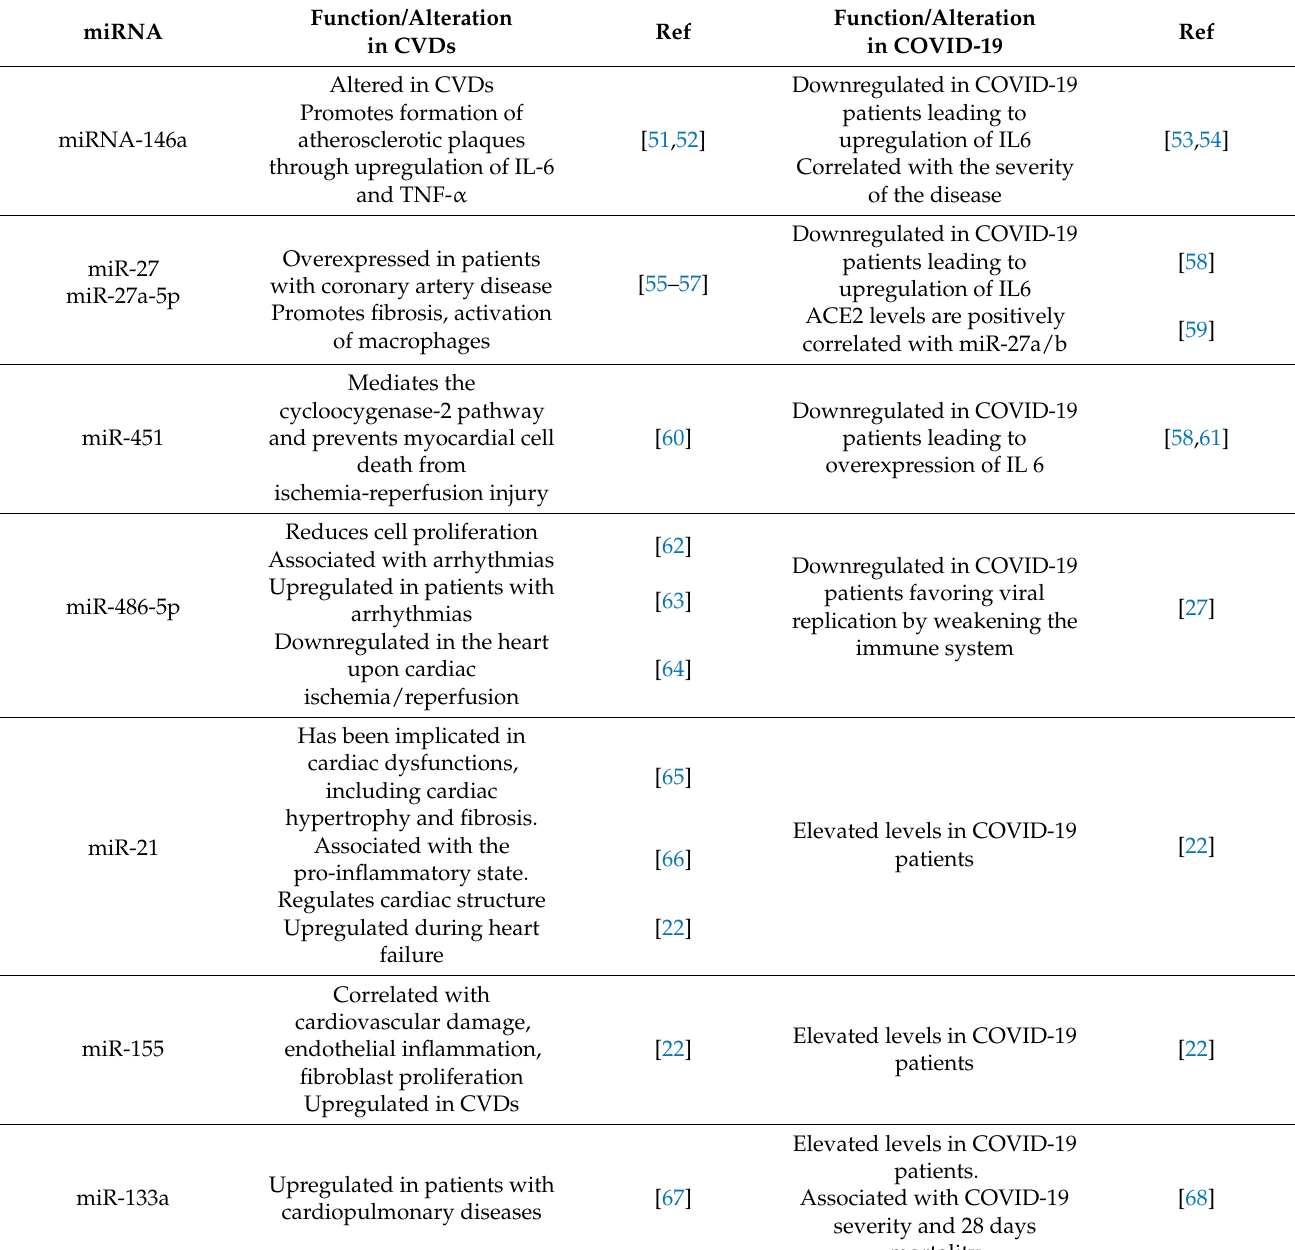
Table 1. Circulating miRNAs associated with COVID-19 and cardiovascular